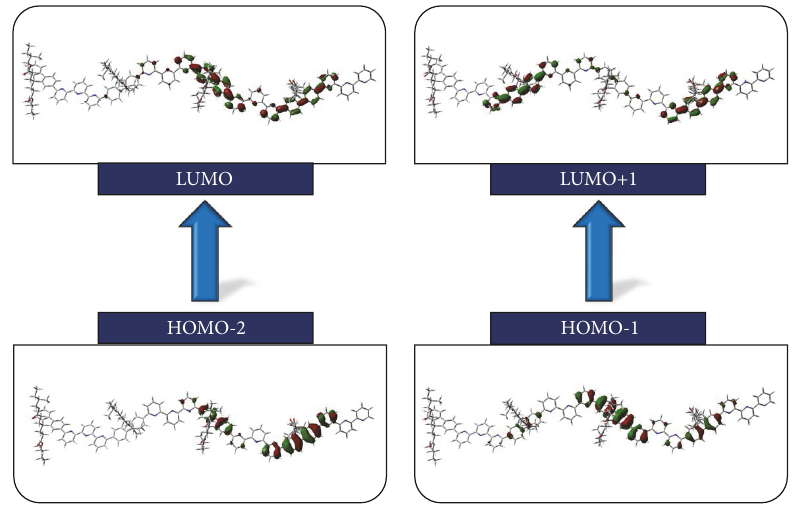
Figure 7: Selected frontier orbitals of the LaPPS71 tetramer with hydrogen atoms